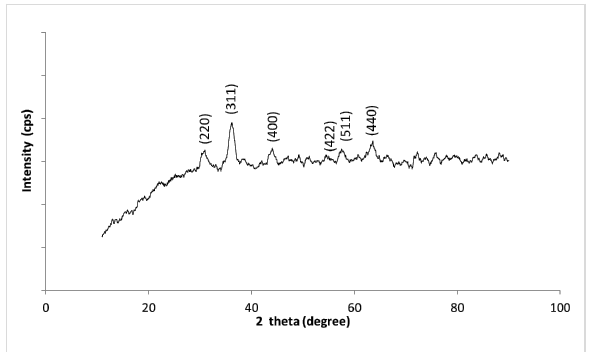
Figure 3: XRD pattern of APTES-functionalized SPION with the peaks correspond to either magnetite or maghemite compared with JCPDS